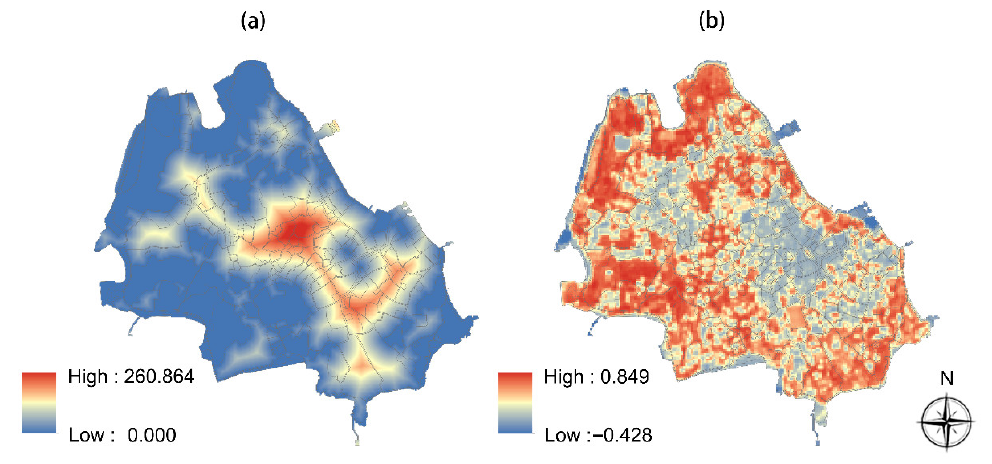
Figure 5. The spatial features of green spaces: ( a ) distance to green spaces (DtGS) and ( b ) normalized difference vegetation index (NDVI).